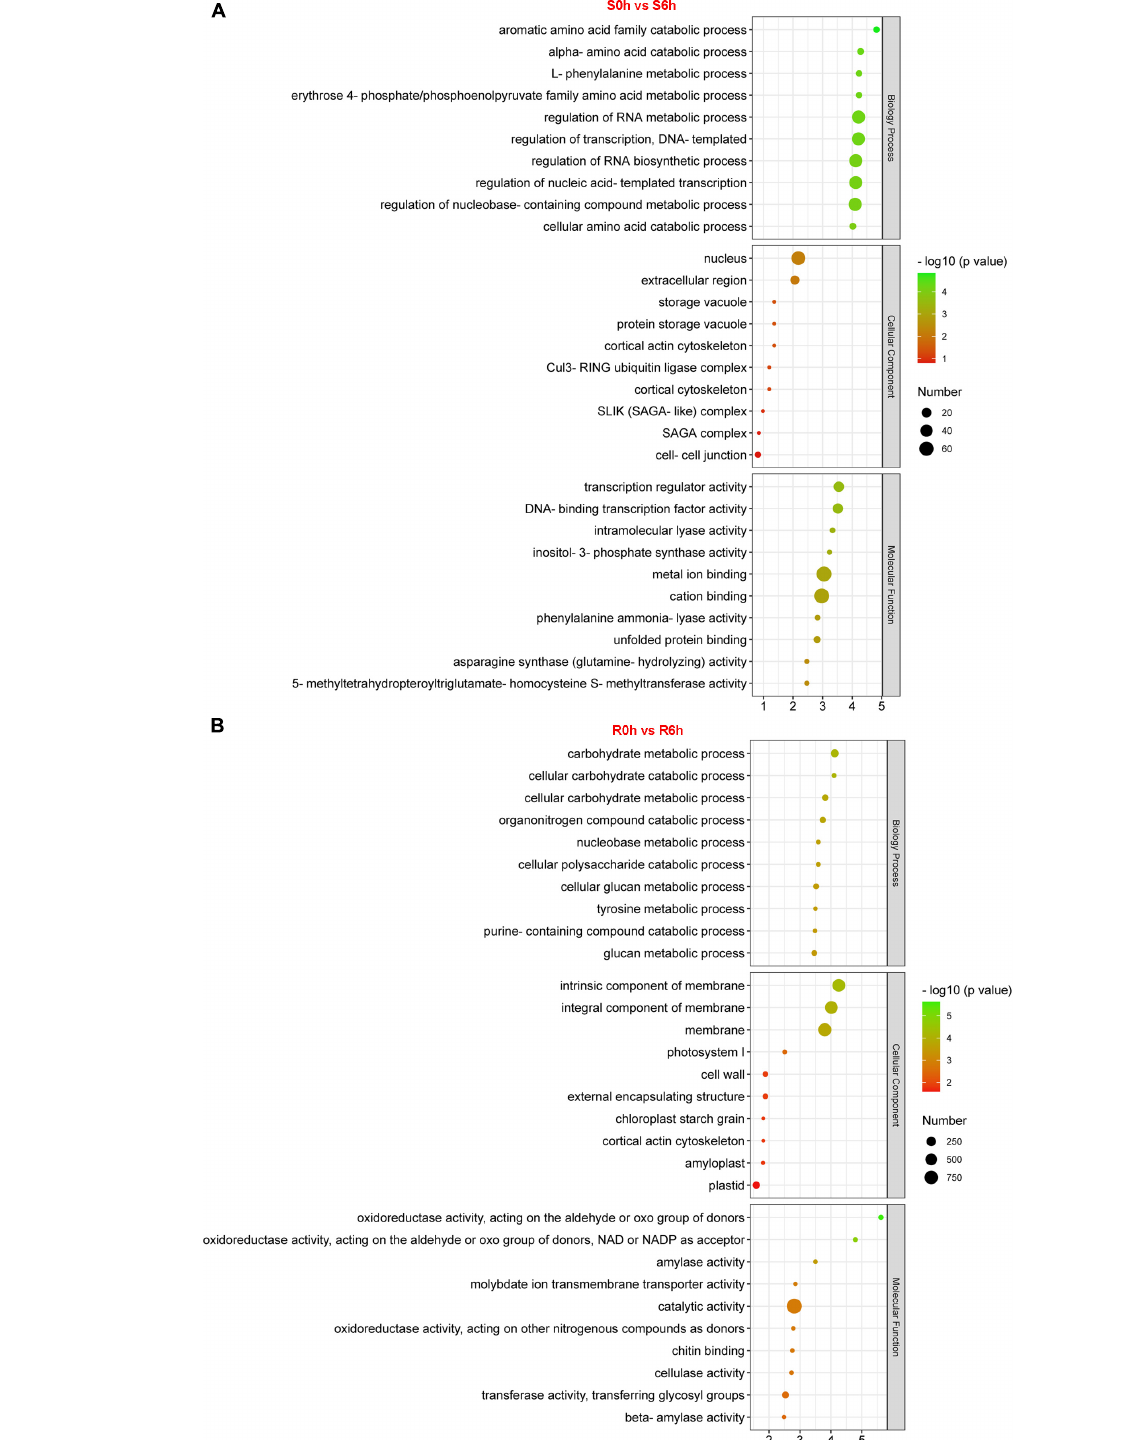
Frontiers in Plant Science |